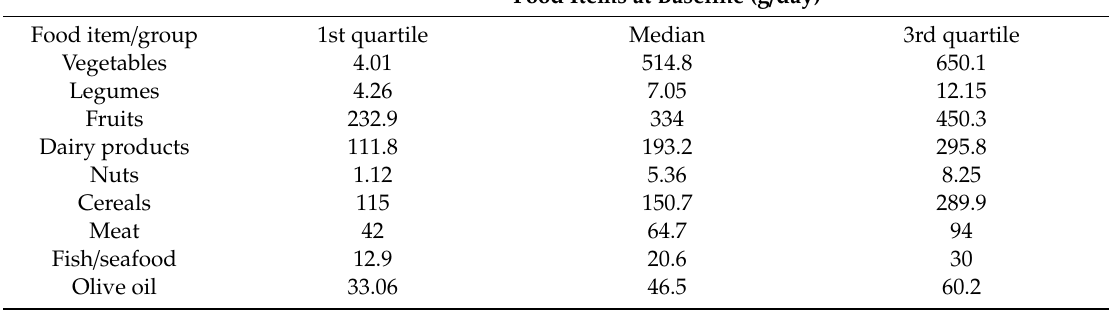
Table 3. Baseline food group consumption of the participants of the EPIC-Greece study for the food items / groups of